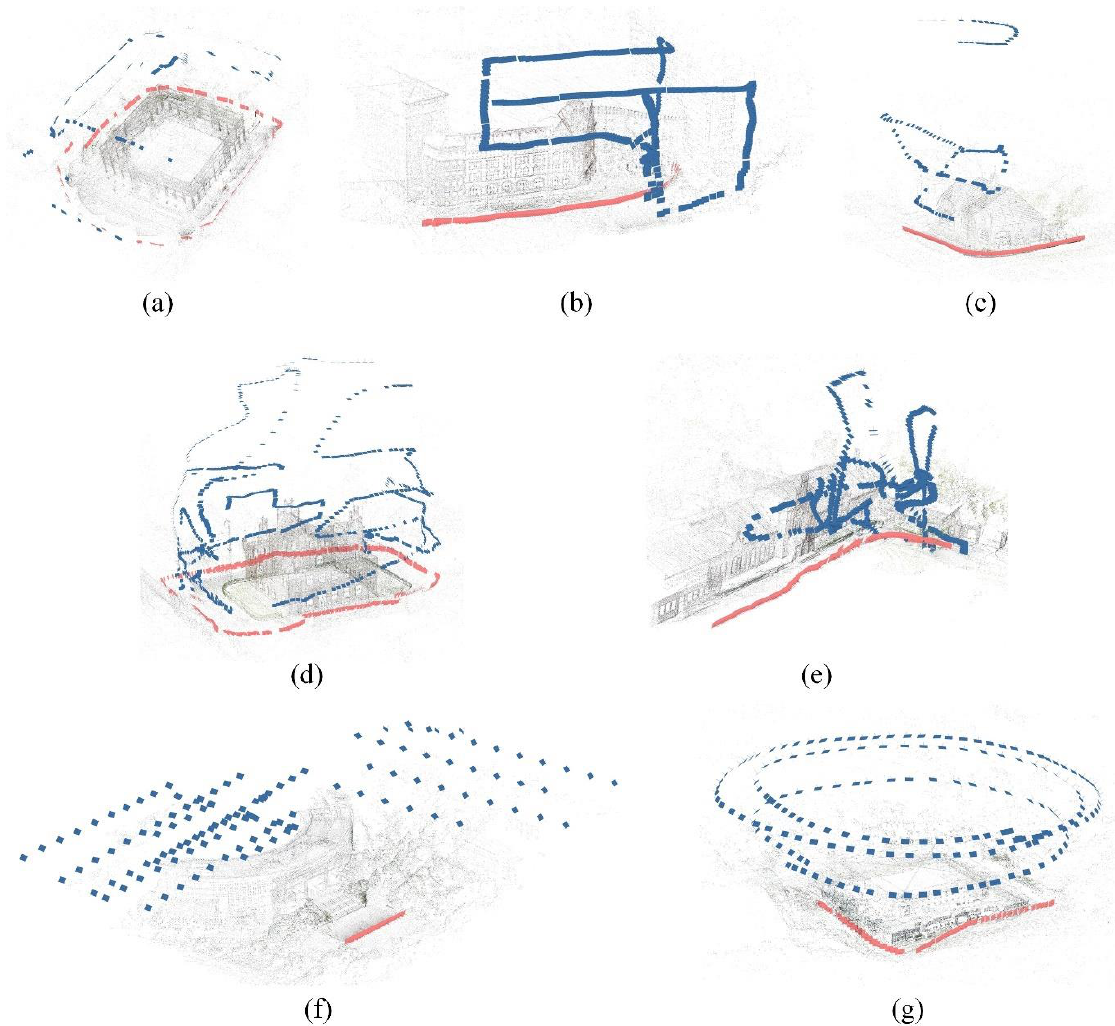
Figure 3. EOPs of images and sparse point clouds after aerial–terrestrial BA in the tested datasets. The blue and pink squares represent aerial and terrestrial images, respectively. ( a ) Rathaus; ( b ) Stadthaus; ( c ) Pferdestall; ( d ) Verwaltung; ( e ) Lohnhalle; ( f ) SWJTU-LIB; ( g ) SZU-YPS.